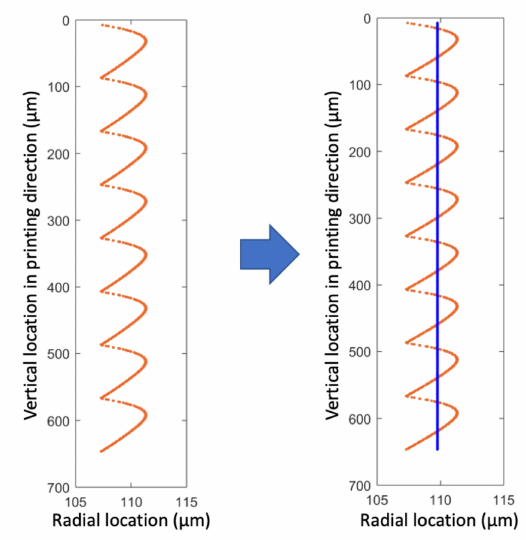
Figure A4. Mean line (blue) on top of surface profile extracted from the simulation